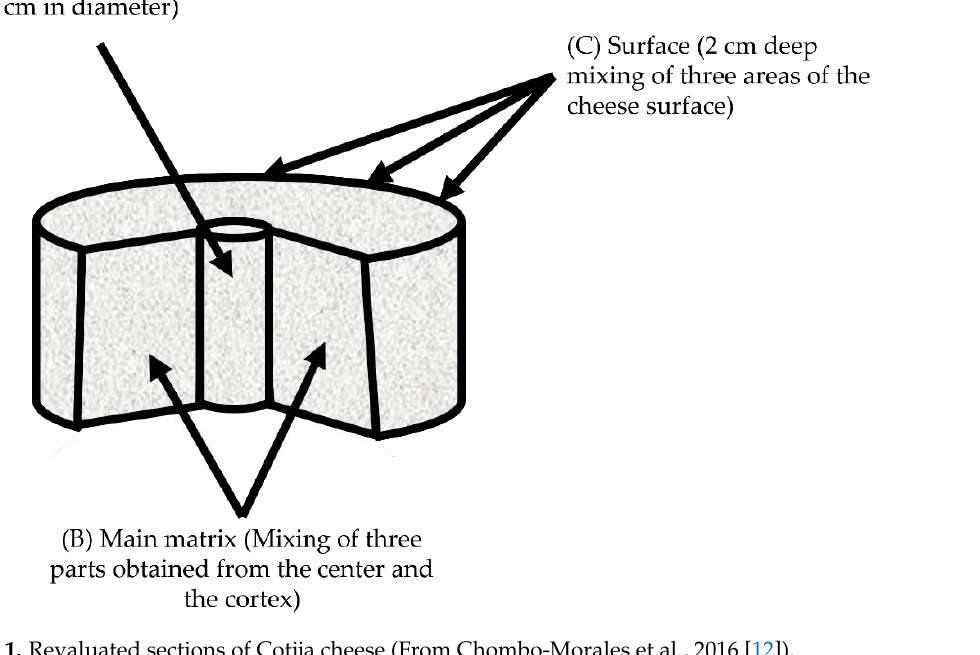
Figure 1. Revaluated sections of Cotija cheese (From Chombo-Morales et al., 2016 [12]). Table 1. Behavior of pathogens in Cotija cheese made with uninoculated milk. Staphylococcus